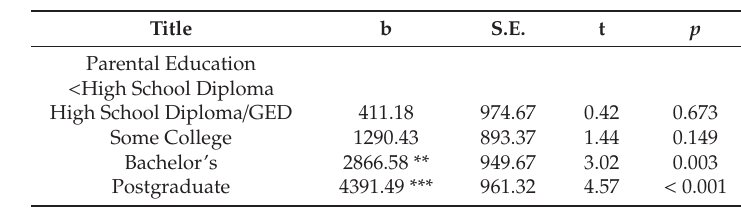
Table 3. The e ff ects of educational attainment on the whole-brain cortex surface area in the pooled sample.